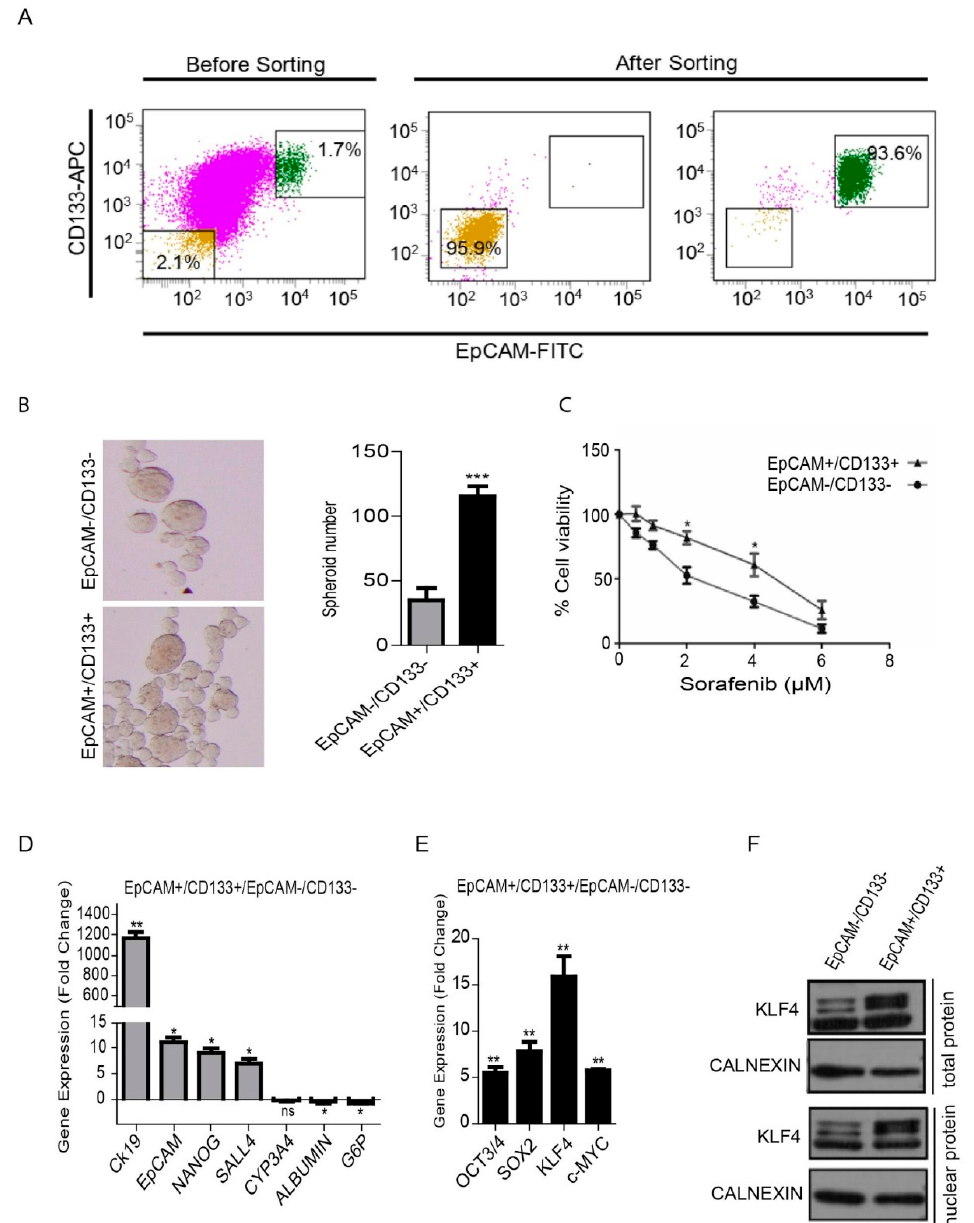
Figure 1. Isolation and analysis of the EpCAM + /CD133 + liver cancer stem cell subpopulation from the HuH-7 cell line. ( A ) Analysis of the EpCAM and CD133 surface marker expressions in the HuH-7 cell line by flow cytometry. The HuH7 cell line was stained with EpCAM-FITC and CD133-APC antibodies, and was sorted using a BD FACS Aria III Cell Sorter. The sorted EpCAM + /CD133 + and EpCAM - /CD133 - cells were stained after cell sorting to determine purity. ( B ) The spheroid formation ability of cells was tested in ultralow attachment plates. Representative images of the spheres formed